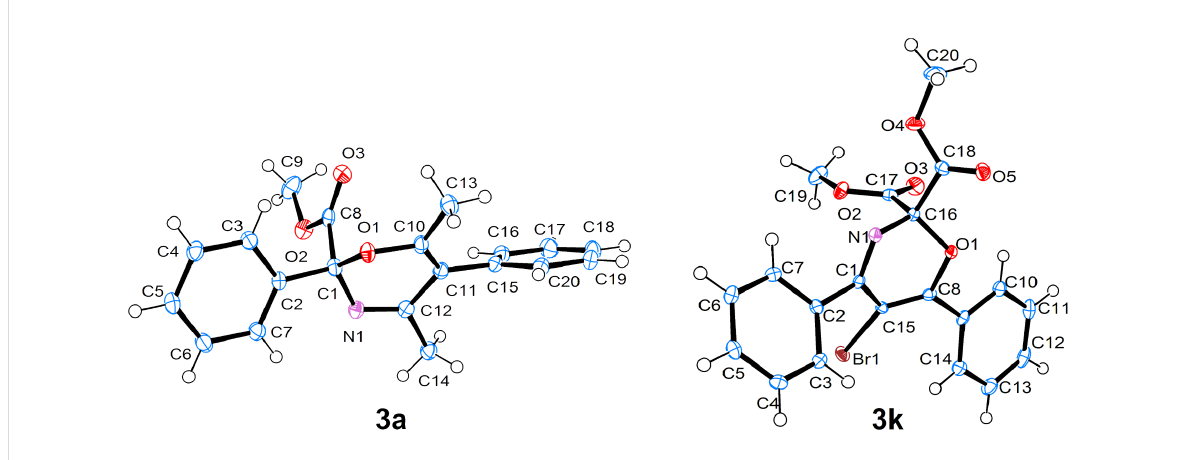
Figure 3: Molecular structures of compounds 3a , k , displacement parameters are drawn at 50% probability level.